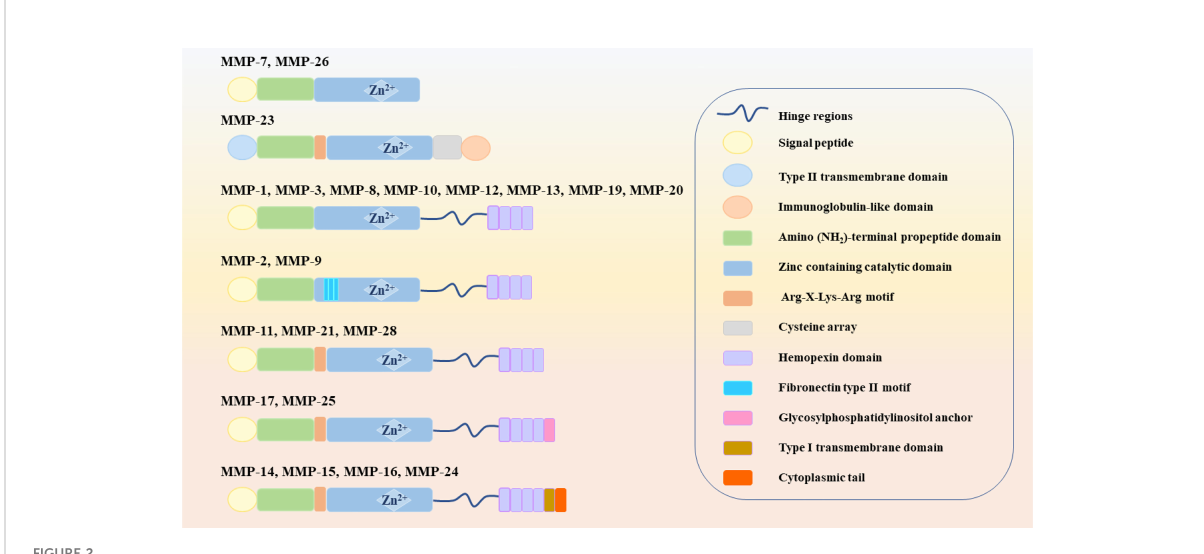
FIGURE 2 Structure of MMPs (MMPs: Matrix